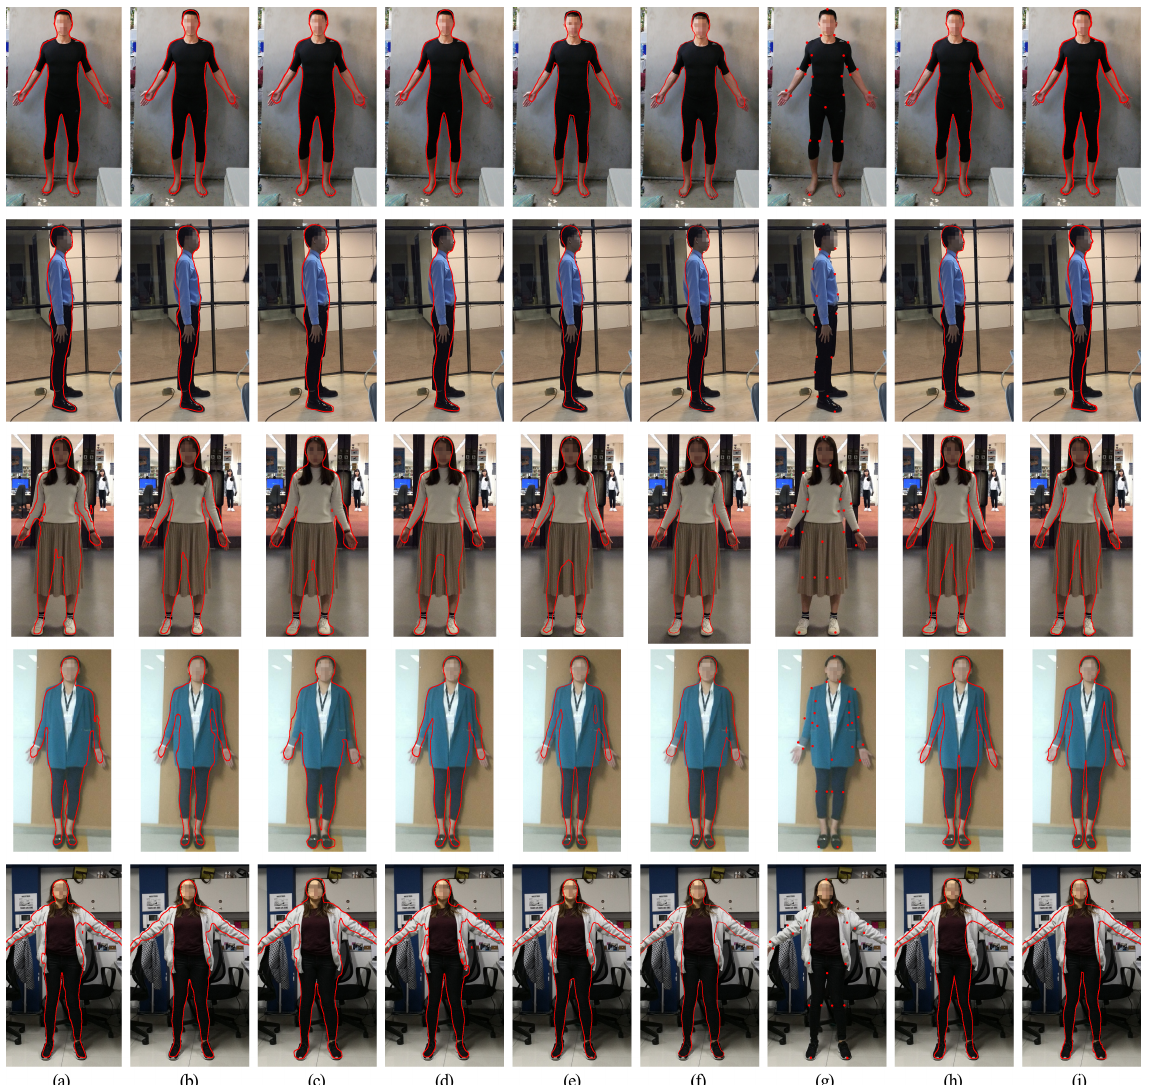
Figure 7. The contour prediction result comparison between other methods and our method, from left to right: ( a ) CE2P, ( b ) Deeplabv3+, ( c ) DenseASPP, ( d ) Gated-SCNN, ( e ) SPNet, ( f ) RePRI, ( g ) our contour keypoint, ( h ) our profile and ( i ) ground